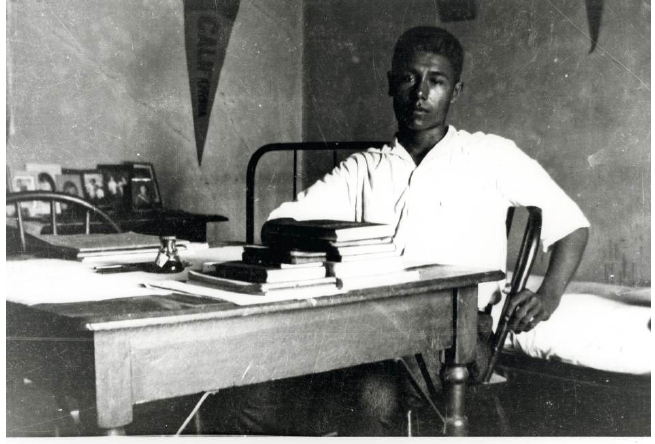
Figure 12. Daniel McKenzie, Kiowa, September 1915. Parker McKenzie Collection, Courtesy of the Oklahoma Historical